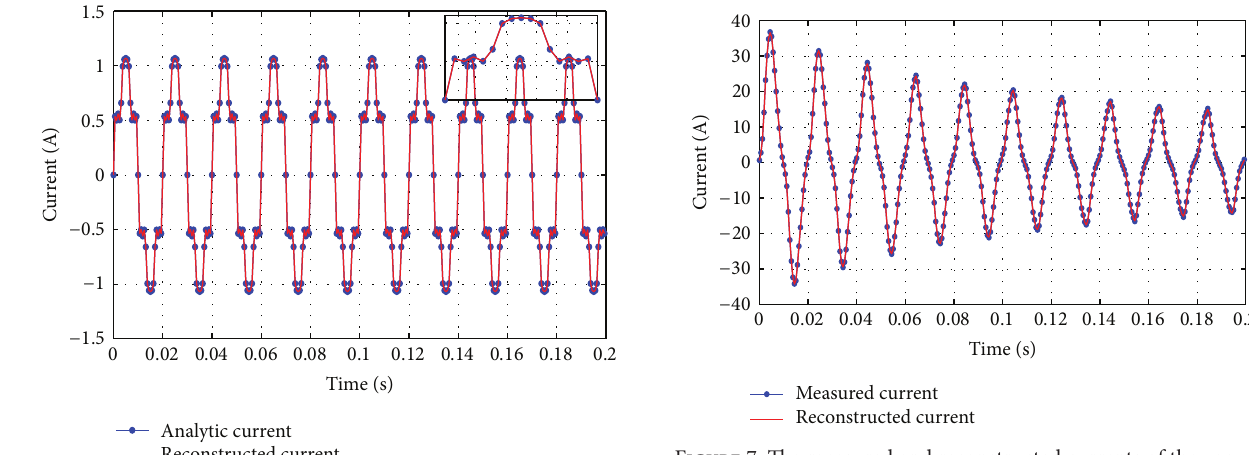
Figure 7: The measured and reconstructed currents of the vacuum